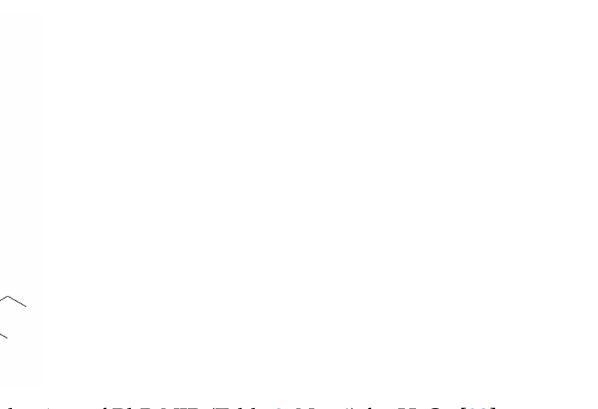
Figure 43. The proposed sensing mechanism of RhB-NIR (Table 3, No. 4) for H 2 O 2 [93]. Sensor No.5 (Table 3) was also a kind of reaction-type sensor used for ATP detec- tion [94] and Sensor No. 6 (Table 3) discriminated the ATP as hydrogen bonds formed between diethylenetriamine moiety of the sensor and phosphate groups of the target [95]. Three rhodamine derivatives (probes 1, 2, 3) were constructed by Liu Y. et al. (Table 3, No. 5) [94] and probe 2 demonstrated a specific target at mitochondrial and the real-time detection of ATP in living cells. Tikum A. F., et al. synthesized a NIR-fluorescent sensor (Table 3, No. 6), revealing a turn-on fluorescent response by changing the solution color (from colorless to purple) through the interaction with ATP (Figure 44) [95].